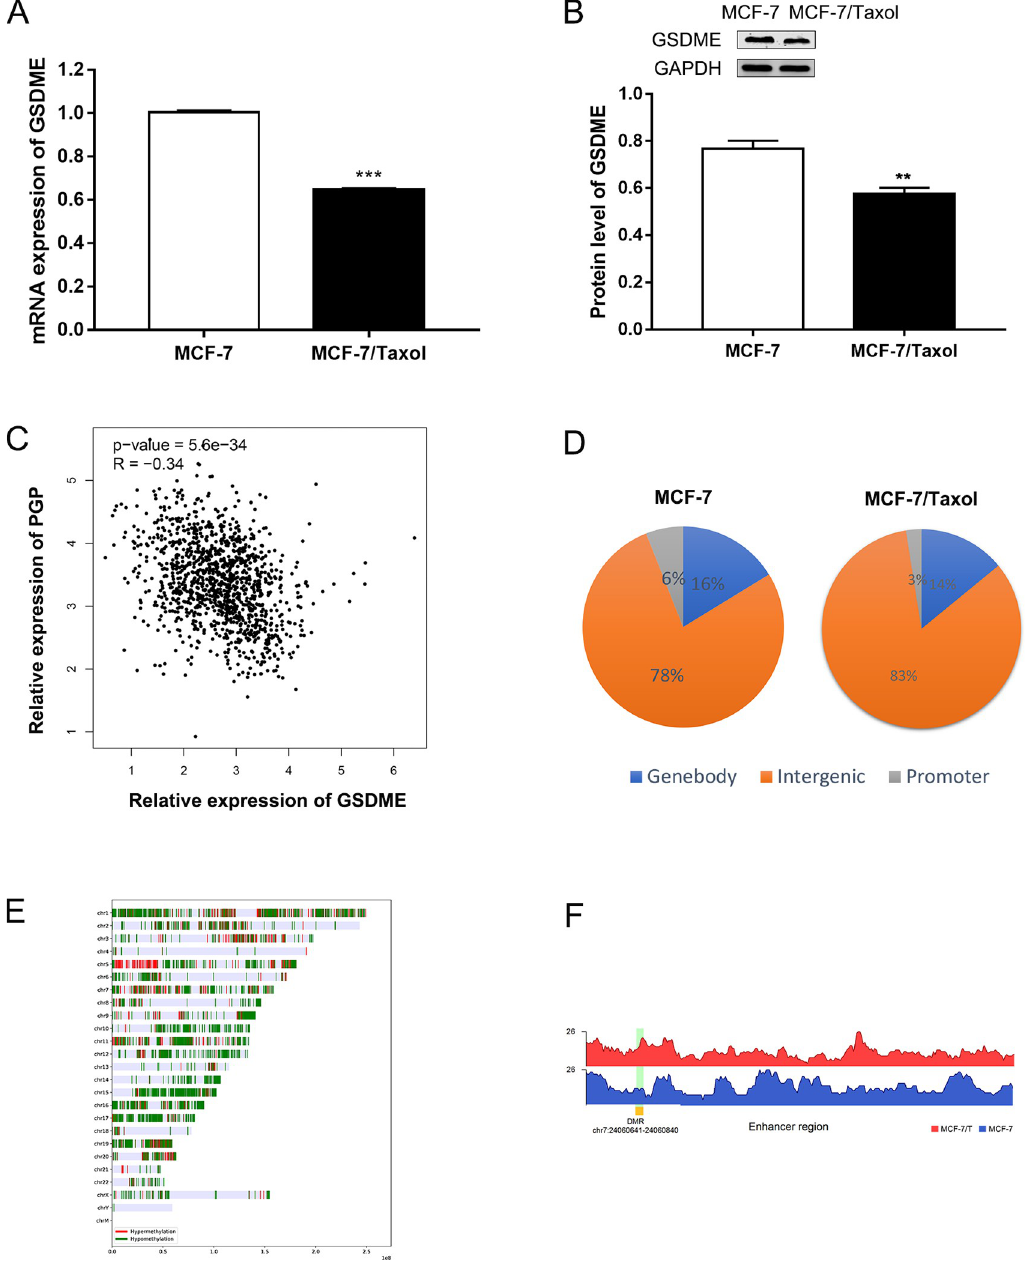
Fig 2. GSDME expression is regulated by epigenetic mechanisms in breast cancer cells. A and B. qRT-PCR and Western blot analysis showed GSDME expression in MCF-7 and MCF-7/Taxol cells. �� P < 0.01, ��� P < 0.001 vs control group. C. Pearson’s correlation analysis of the relative expression levels of GSDME and the relative p-GP protein expression levels in the same set of tissues. D. The distribution map of methylation peaks in the whole genome. E. The distribution of DMRs in chromosomes. F. Differential methylation peaks in the enhancer